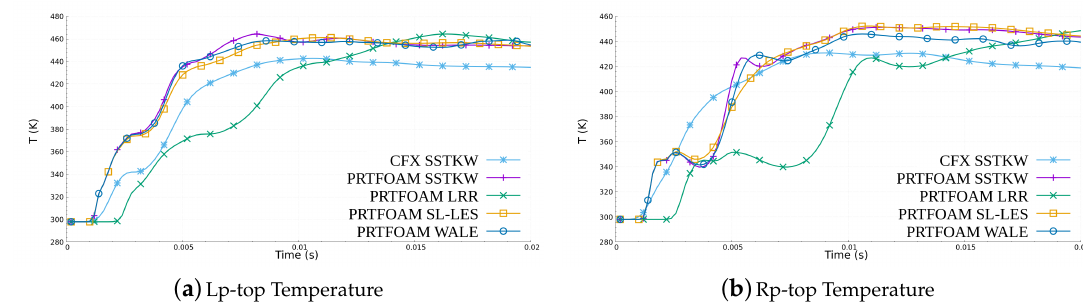
Figure 17. Temperature–time curves of the simulation results of different models at the ( a ) Lp-top and ( b ) Rp-top sampling point. The temperature at the top of the shell increases gradually and stabilizes at approximately 450 K at 0.01 s. The temperature fluctuation of the Rp-top sampling point is significantly larger than that of Lp-top, and the simulation result of PRTFOAM LRR has a large deviation.